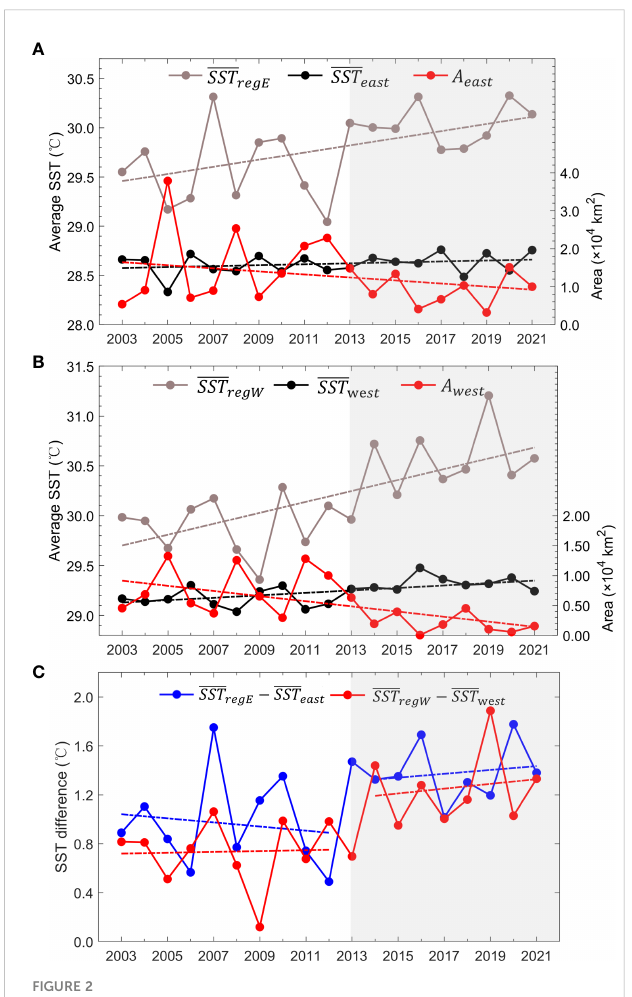
FIGURE 2 The interannual variations and long-term trends of the mean sea surface temperature ( SST east ) and area ( A east ) in the east upwelling sea region of Hainan Island surrounded by 29.0 °C isotherm and mean sea surface temperature ( SST regE ) in the east non-upwelling region (A) ;the same indices ( SST west , A west ) in the west upwelling sea region of Hainan Island surrounded by 29.5 °C isotherm and mean sea surface temperature ( SST regW ) in the west non-upwelling region (B) ; the SST difference between upwelling regions and surrounding non-upwelling regions (C) from 2003 to